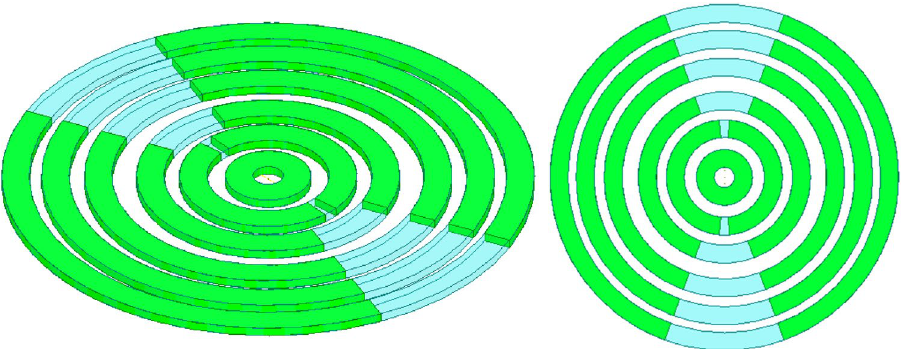
Figure 13. Full ring structure, isometric view (left), and top view (right).